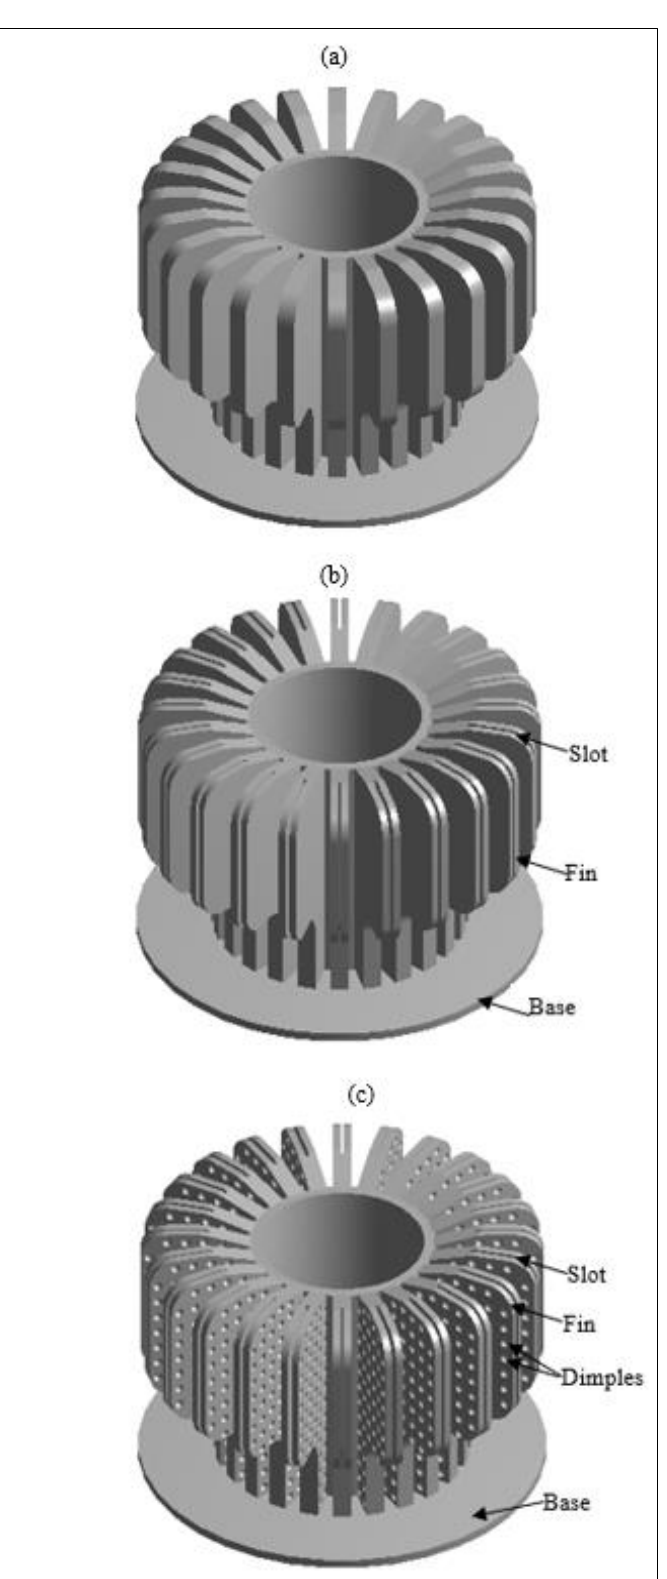
Figure 1: SS (a) Type A (Radial HS with plain fins or convectional) (b) Type B (HS with slotted fins) (c) Type C (HS with slotted and dimpled